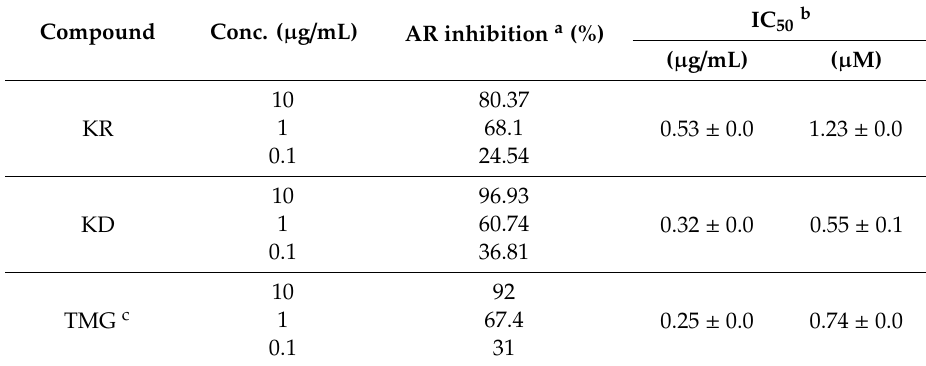
Table 5. IC 50 values of KR and KD.